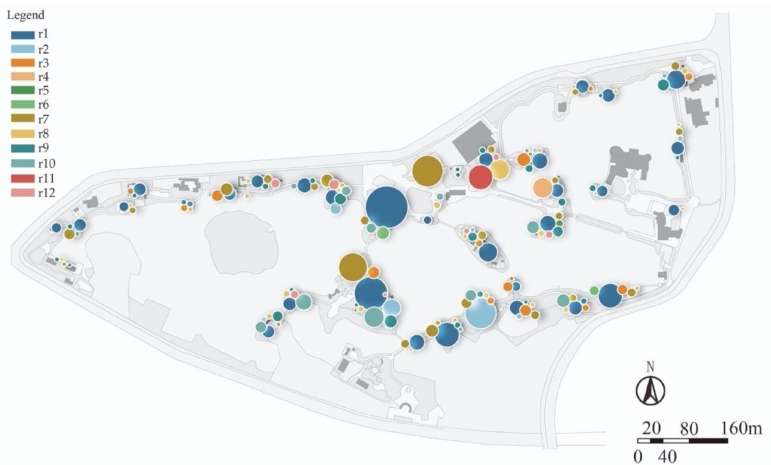
Figure A5. Spatial distribution of various recreational activity users in Liuhuahu Park.